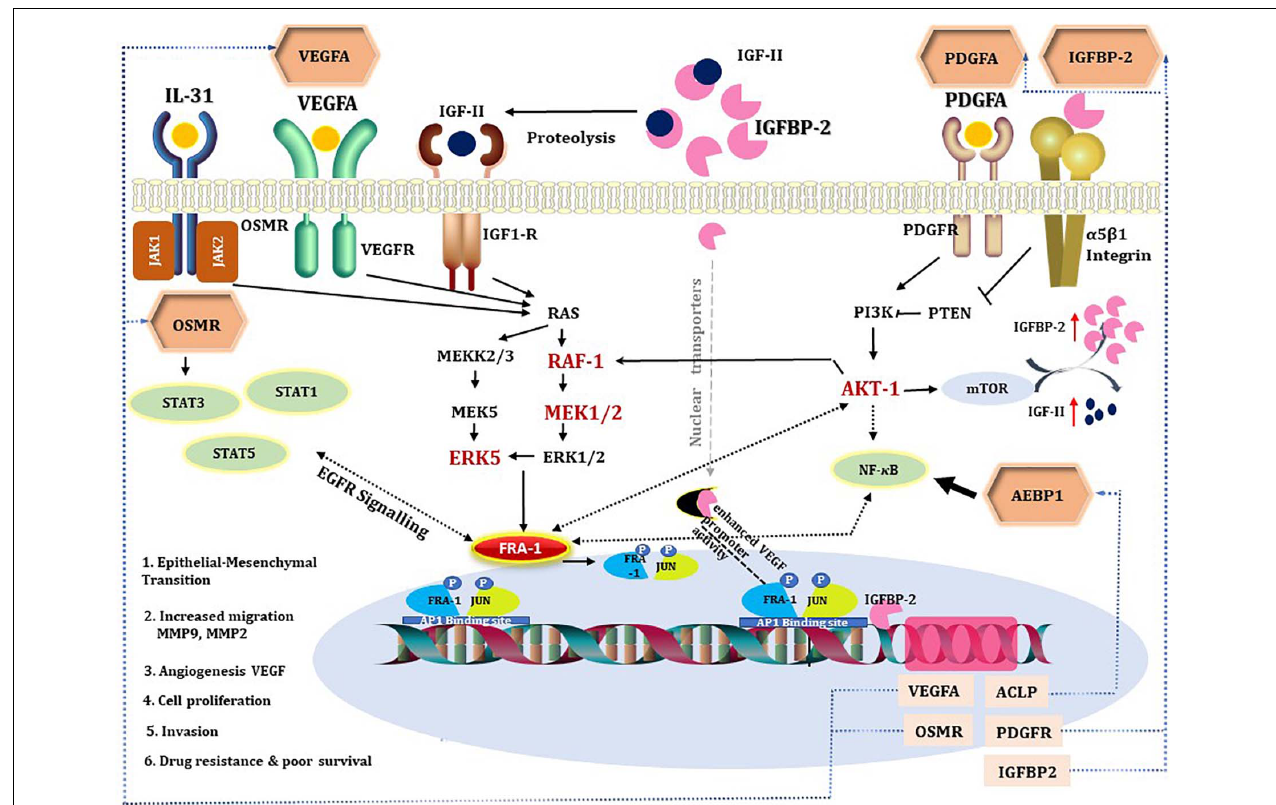
FIGURE 5 | A diagram combining prior knowledge about the role of IGFBP2 in GBM and the gene regulatory network developed in the study. The hexagons are master regulators identified in our analysis. All the intermediates of the gene regulatory network are colored red if upregulated in STS and black if not present in the network. Dotted black line indicates the knowledge is through literature and continuous black line if known through gene regulatory network. Blue dotted lines represent gene regulatory connections between master regulators and their corresponding genes transcribed by target transcription factors. VEGFA, PDGFA, IGFs, and IL-31 activate RAF/MEK/ERK signaling, which mediate cell survival through PI3K-AKT pathway (Yao et al., 2016; Simpson et al., 2017). MEK2/RAF1/ERK5 and AKT-1 are found to be upregulated in STS, suggestive of activated ERK signaling, which can contribute to drug resistance (Abrams et al., 2010; Salaroglio et al., 2019). IGFBP2 activates IGFR either by increasing bioavailability of IGFs or by direct interaction with its functional domain. Integrin acts as receptor for IGFBP2 extracellular signals (Schütt et al., 2004; Yau et al., 2015) and modulates NF- κ B signaling. IGFBP2 by nuclear translocation (Azar et al., 2011) is involved